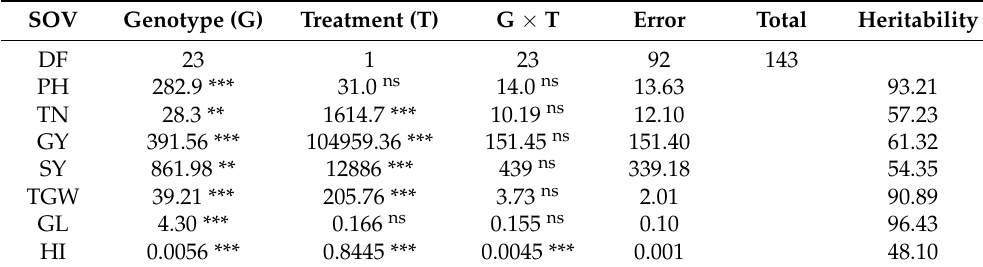
Table 3. Mean squares values from Analysis of variance (ANOVA) for 7 maturity related parameters of rice.